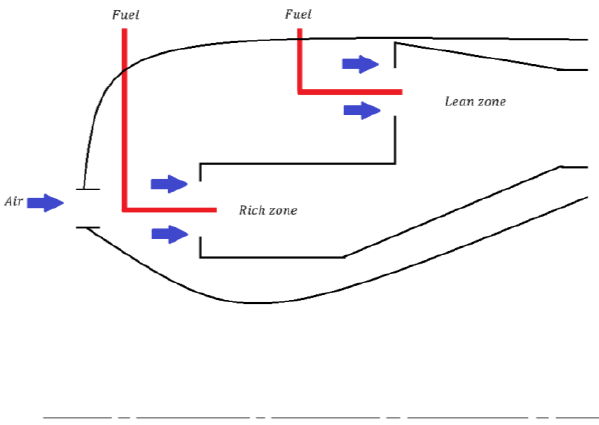
Fig. 6. Combustor with graduated combustion zone (basing on